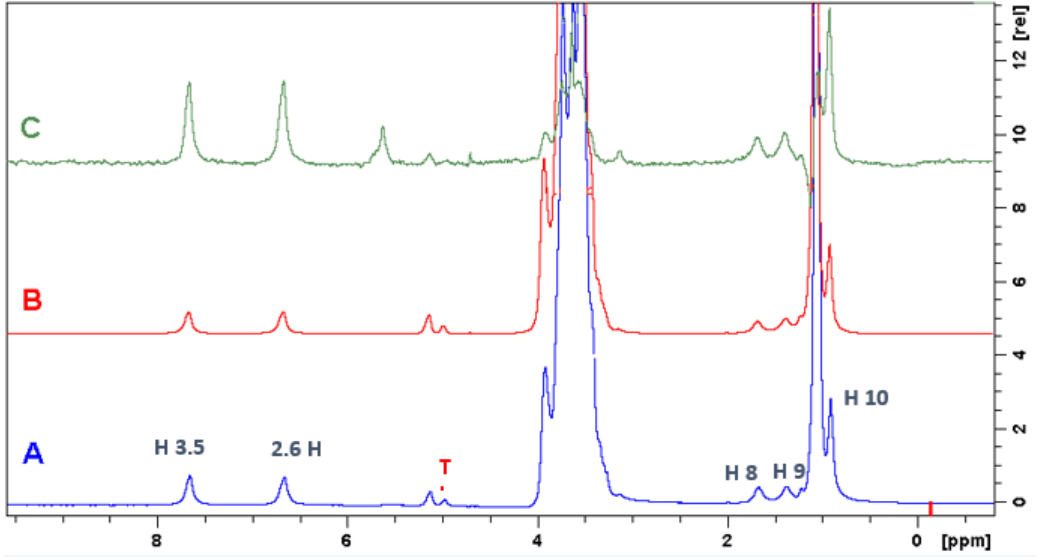
Figure 4. ( A ) 1 H NMR spectrum (400 MHz, D 2 O/residual H 2 O reference at 4.7 ppm) of the BTB/HP- β CD/SL complex (50 mmol L − 1 ); ( B ) control spectrum (radiating at 30 ppm); ( C ) STD spectrum (radiating at − 0.5 ppm). Total saturation time 2.55 s.